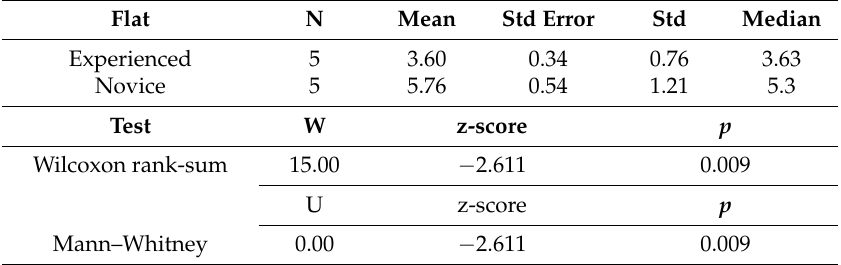
Table 11. Test for correlation between user skills level and task duration in flat design.